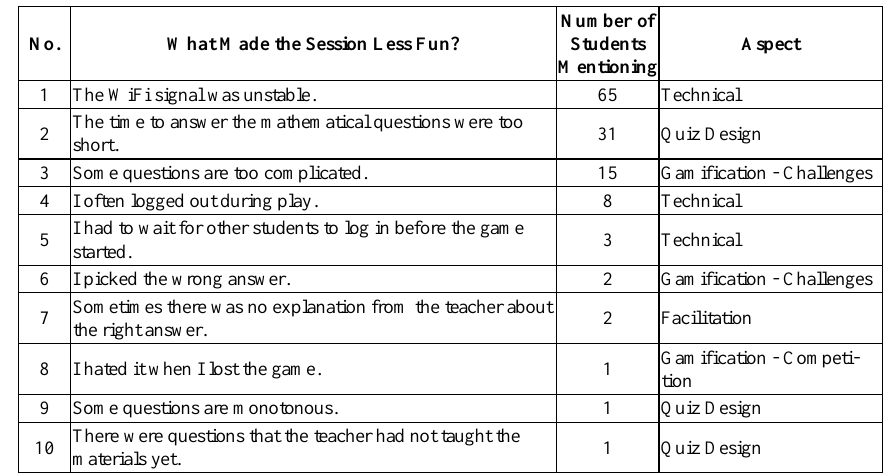
Table 8. Questionnaire Result, Part 3, Question